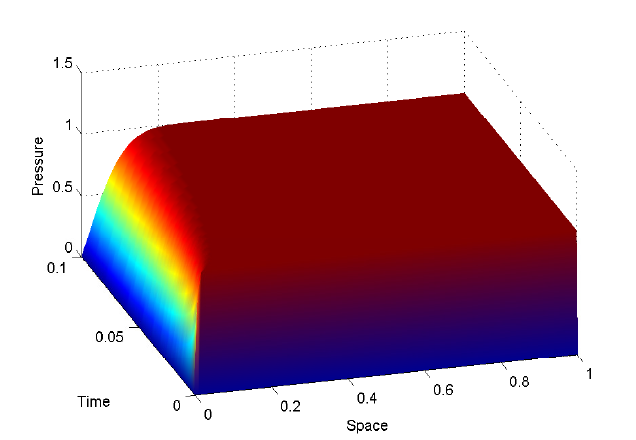
Figure 2. An accurate enough approximation for pressure in the case κπ (cid:112) ρ ( λ + 2 µ ) < 1 obtained truncating the series of the analytical